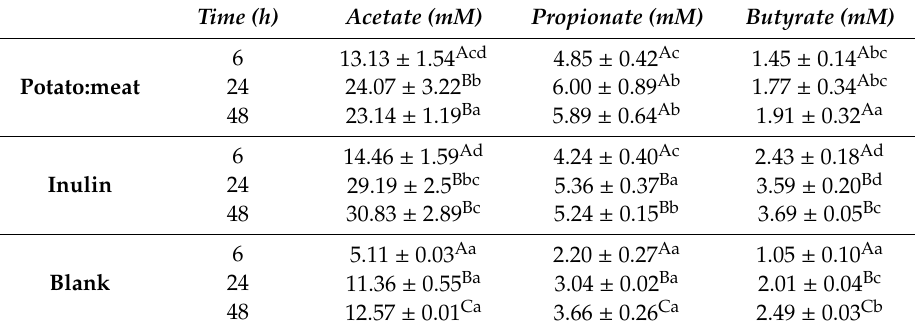
Figure 3. Gas increment during fermentation time (kPa). Results are expressed as mean and standard deviation. The data marked by the same letters were not significantly different ( p > 0.05). Different uppercase letters for comparison within each fermentable source at a different time and lowercase letter for comparison within the different fermentable source at the same time, indicating significant differences at p < 0.05.